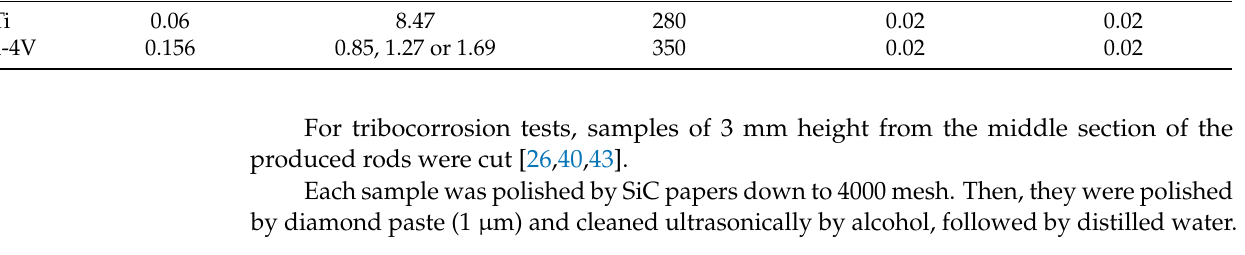
Table 2. Parameters used to produce NiTi and Ti-6Al-4V samples by LB-DED LENS process.